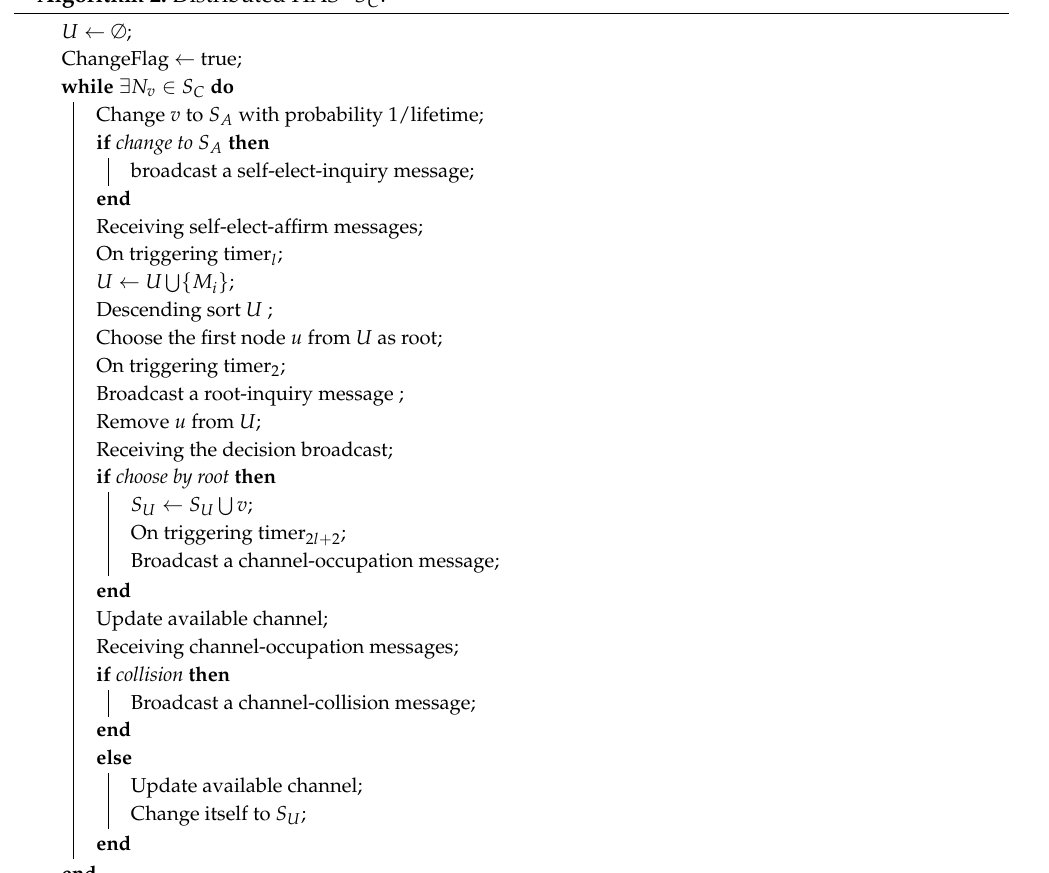
Algorithm 2: Distributed HAS 4 S C